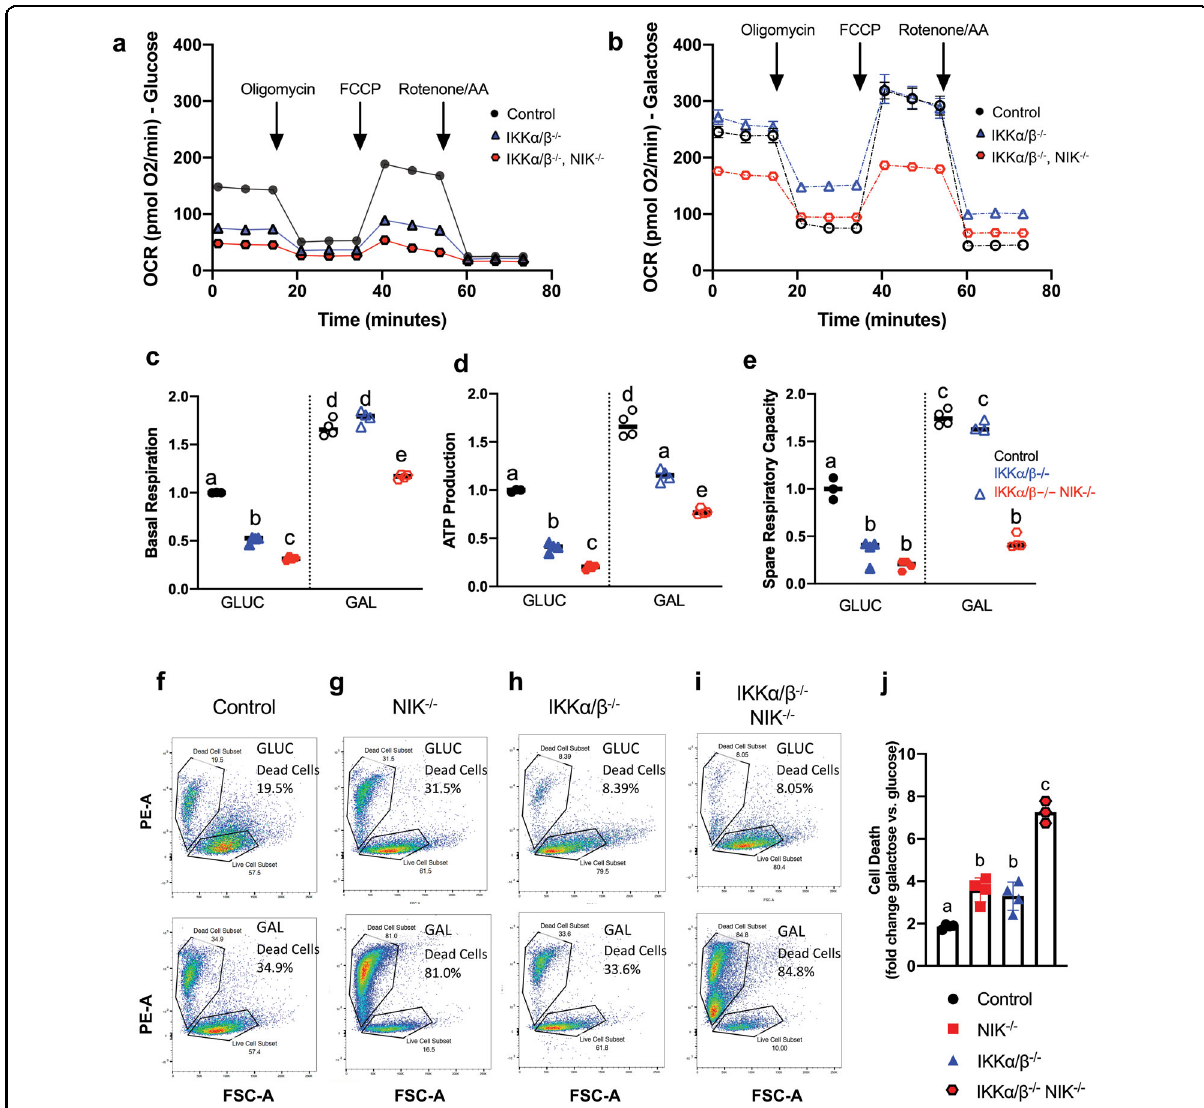
Fig. 5 NIK regulation of mitochondrial metabolism and cell survival is independent of IKK. a , b Oxygen consumption rate (OCR) was measured using the Seahorse Mito Stress test with control cells (see Figs. 2b and 4a, b), IKK α / β − / − cells and IKK α / β − / − , NIK − / − lines that were cultured in 18 mM glucose (GLUC) ( a ) or 18 mM galactose (GAL) media ( b ). Data shown are the mean ± SD of ≥ 3 replicates for each cell type in each condition and are representative of at least three independent experiments. OCR values were normalized to cellular DNA content (DRAQ5 relative fl uorescence units (RFUs)). c – e Individual mitochondrial function parameters were calculated from the data shown in a and b and shown as fold change compared to control cells in GLUC. Data for control cells was taken from Fig. 2b. c Basal respiration. Different letters indicate statistical signi fi cance using one-way ANOVA with Tukey post-hoc test. All comparisons have p < 0.0001 except “ a vs e ” ( p < 0.01), “ b vs c ” ( p < 0.001). d ATP production. All statistical comparisons have p < 0.0001 except “ a vs e ” ( p < 0.01), and “ b vs c ” ( p < 0.01). e Spare respiratory capacity. All statistical comparisons have p < 0.0001 except “ a vs b ” ( p < 0.01), “ a vs c ” ( p < 0.05). f – i Representative Flow cytometry analysis of cell death using propidium iodide staining. Indicated BT25 GBM cells were grown for 48 h in either 18 mM glucose (upper panels) or galactose media (lower panels). j Fold change in cell death induced by shifting from GLUC to galactose media for 48 h (% dead cells in galactose / % dead cells glucose). Different letters indicate statistical signi fi cance using one-way ANOVA with Tukey post-hoc test. For “ a vs b ” p < 0.05, “ b vs c ” p < 0.0001; n = 3 – 4 independent experiments, n ≥ 10,000 cells per condition. Error bars indicate mean ±